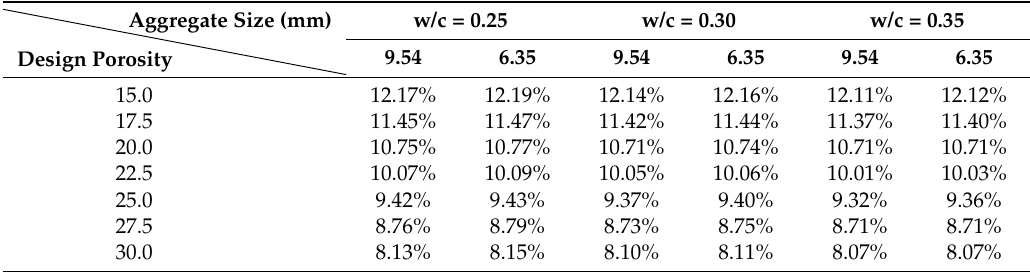
Table 3. Percentage of initial emissions recoverable via CO 2 sequestration for 1 m 3 of pervious concrete. PorosityAggregate Size (mm) w/c = 0.25 w/c = Design